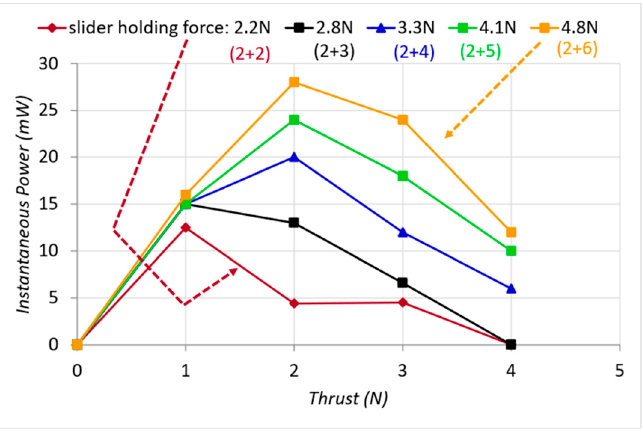
Figure 23. Instantaneous mechanical power output and the effect of additional sheet metal flat springs at the back of the stator.